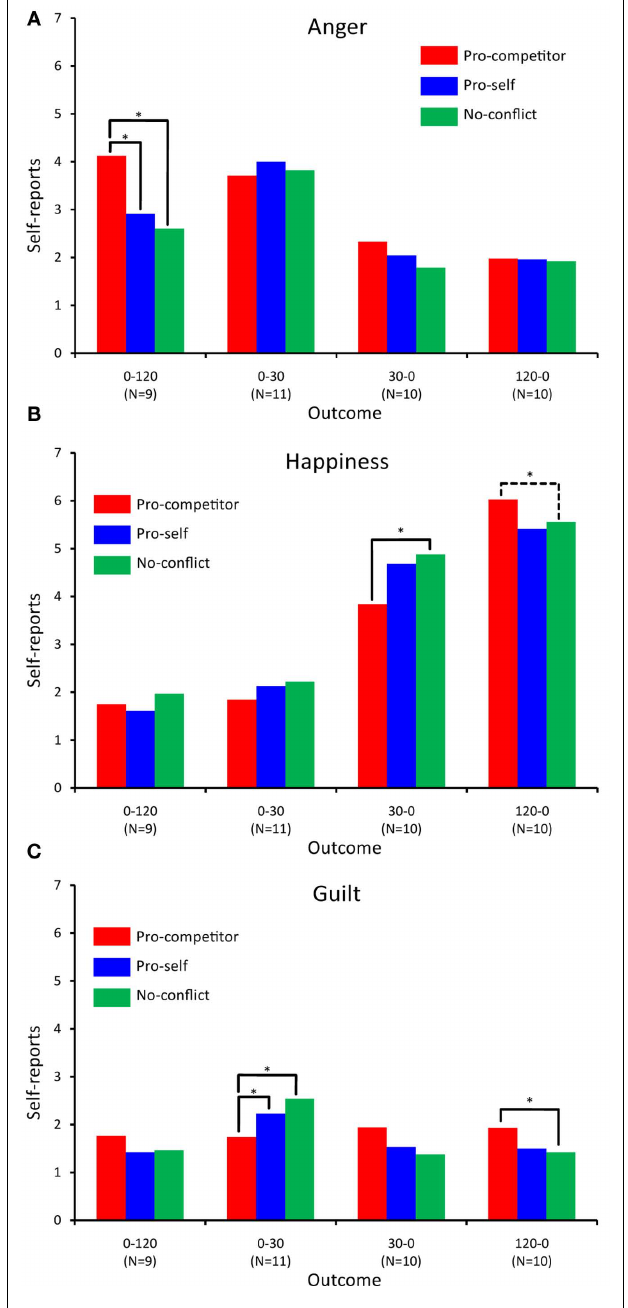
FIGURE 2 | Effects of arbitration on self-reported emotions as a function of outcome. Interactive effects of outcomes and arbitration. (A–C) Pro-competitor arbitration increases anger for high-loss (0–120), reduces guilt for low-loss (0–30), reduces happiness for low-gain (30–0), and increases guilt for high-win